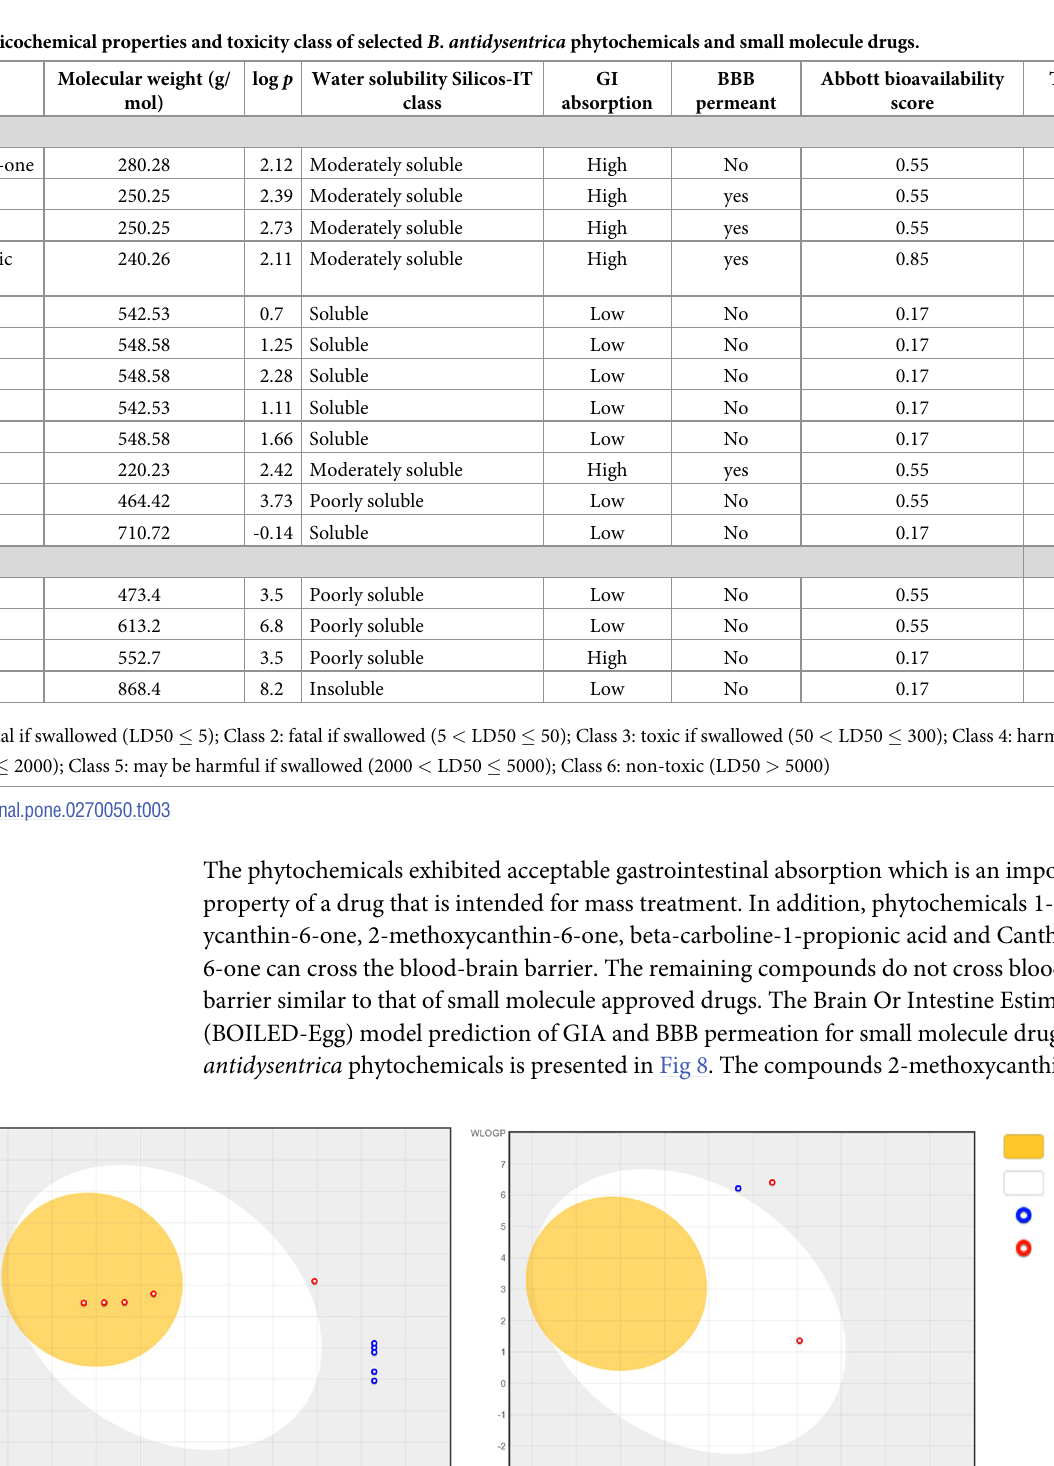
Fig 8. BOILED-Egg model of small molecule standard drugs and selected B . antidysentrica phytochemicals.